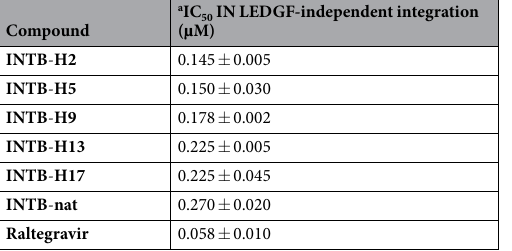
Table 2. ODN inhibition of the HIV-1 IN LEDGF/p75-independent activity. a Compound concentration required to inhibit the HIV-1 IN catalytic activities, in the absence of LEDGF, by 50%. Raltegravir has been used as a reference. See main text for